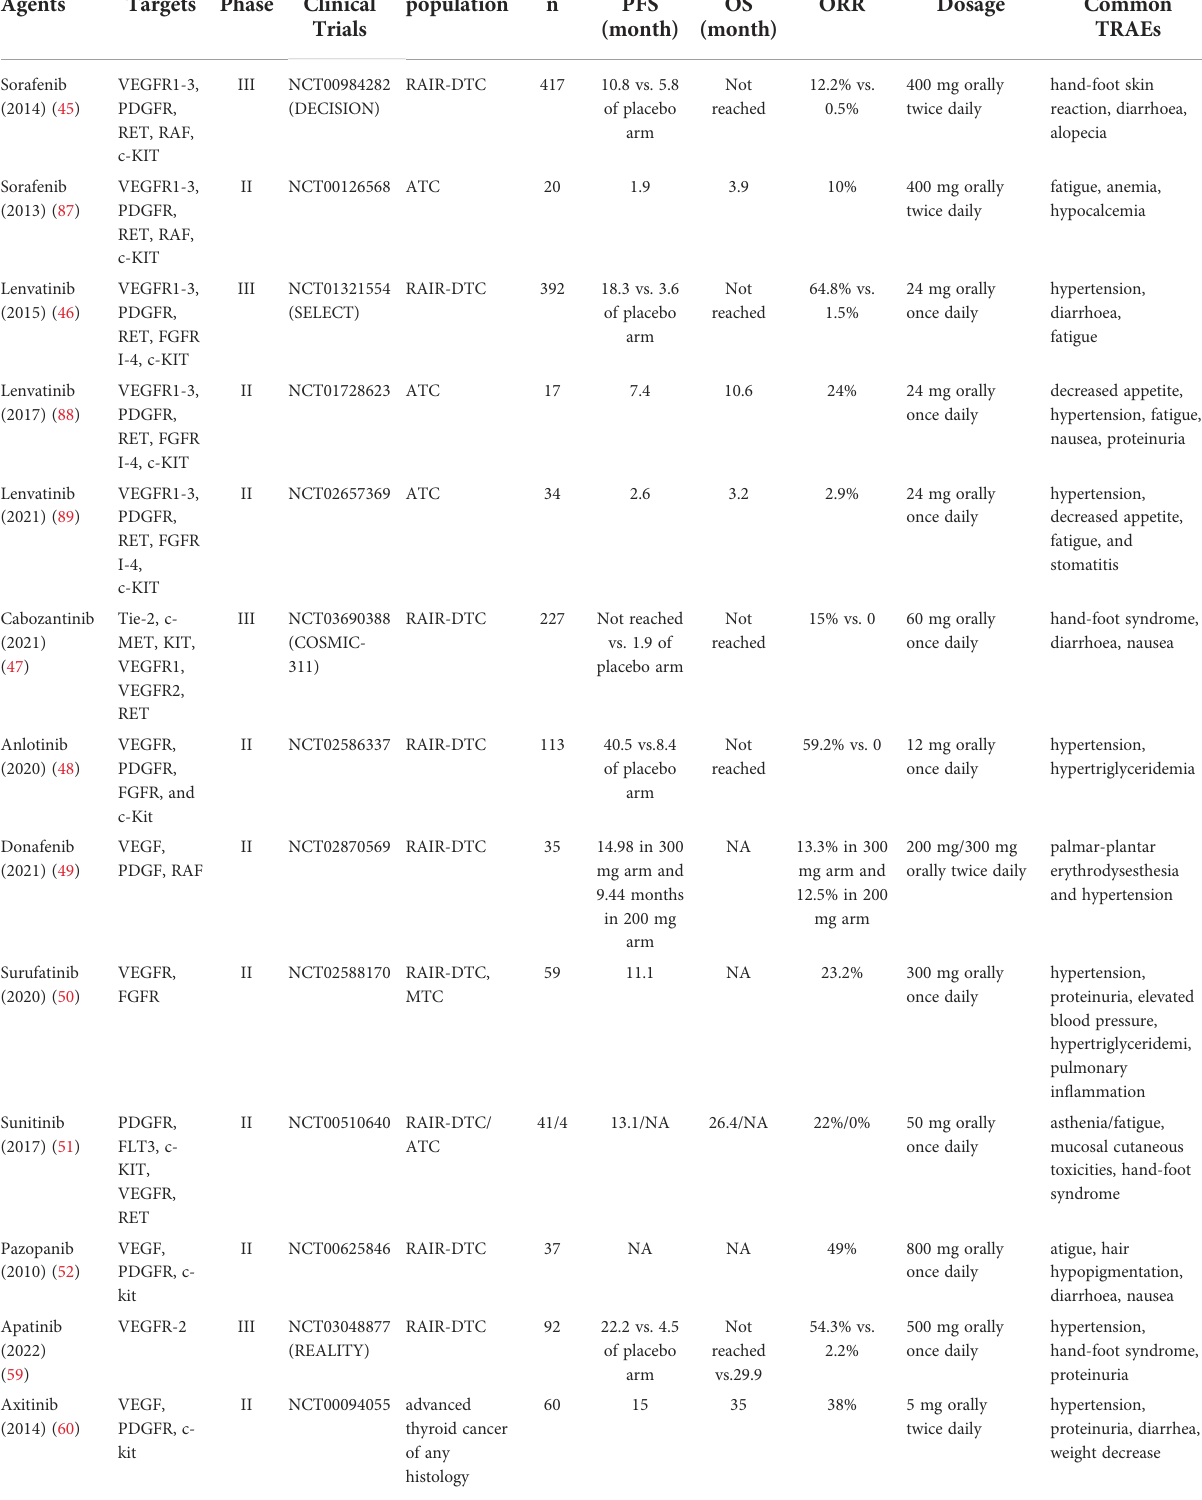
TABLE 2 Published pivot clinical trials for RAIR DTC and